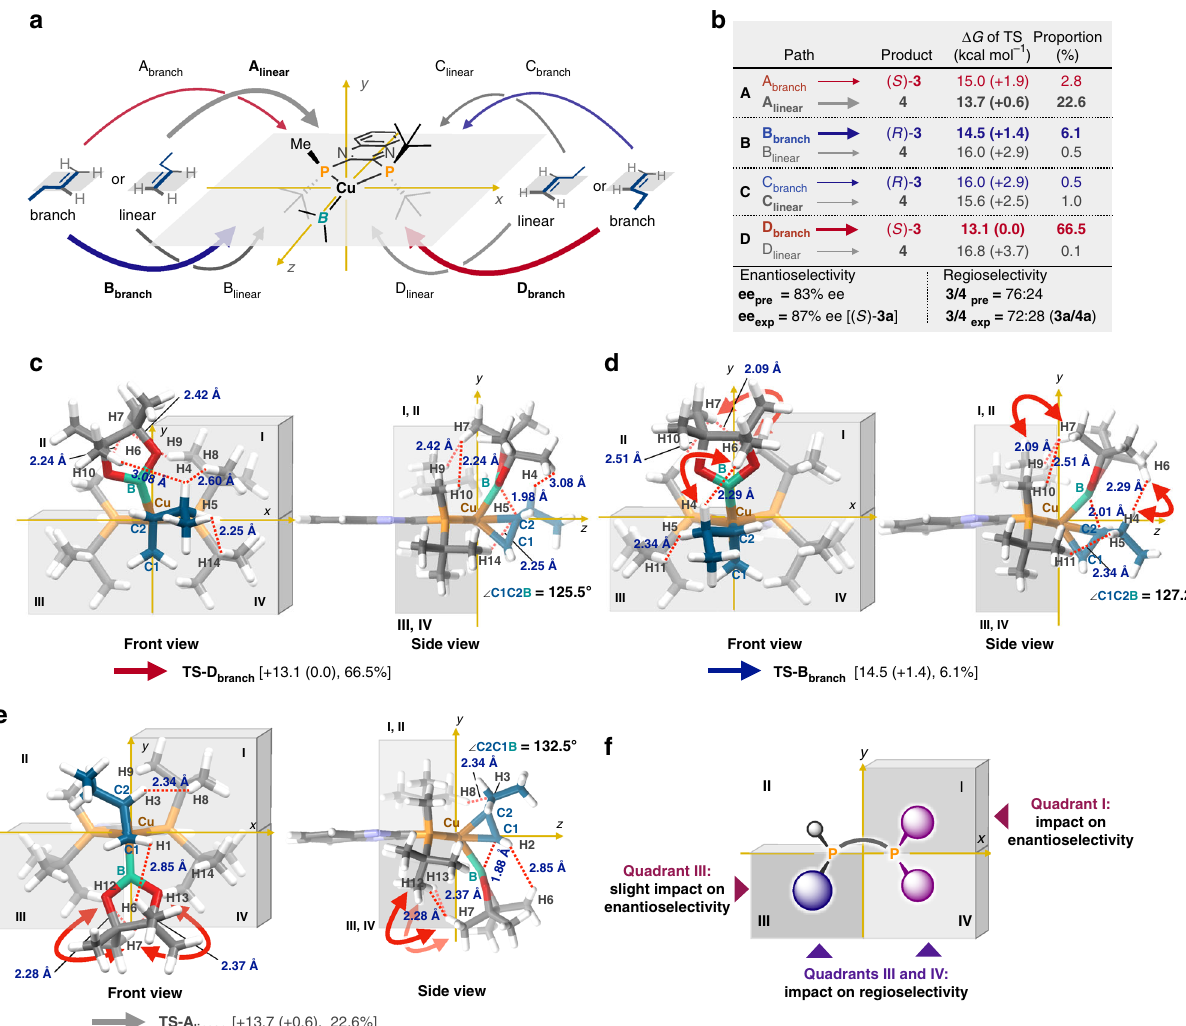
Fig. 3 The fi rst computational study step with ( S )-Quinox- t Bu 3 . a Eight possible reaction routes to products 3 and 4 . b DFT-calculated activation energy values. c Structural analysis of TS-D branch . d Structural analysis of TS-B branch . e Structural analysis of TS-A linear . f Design guidelines from a